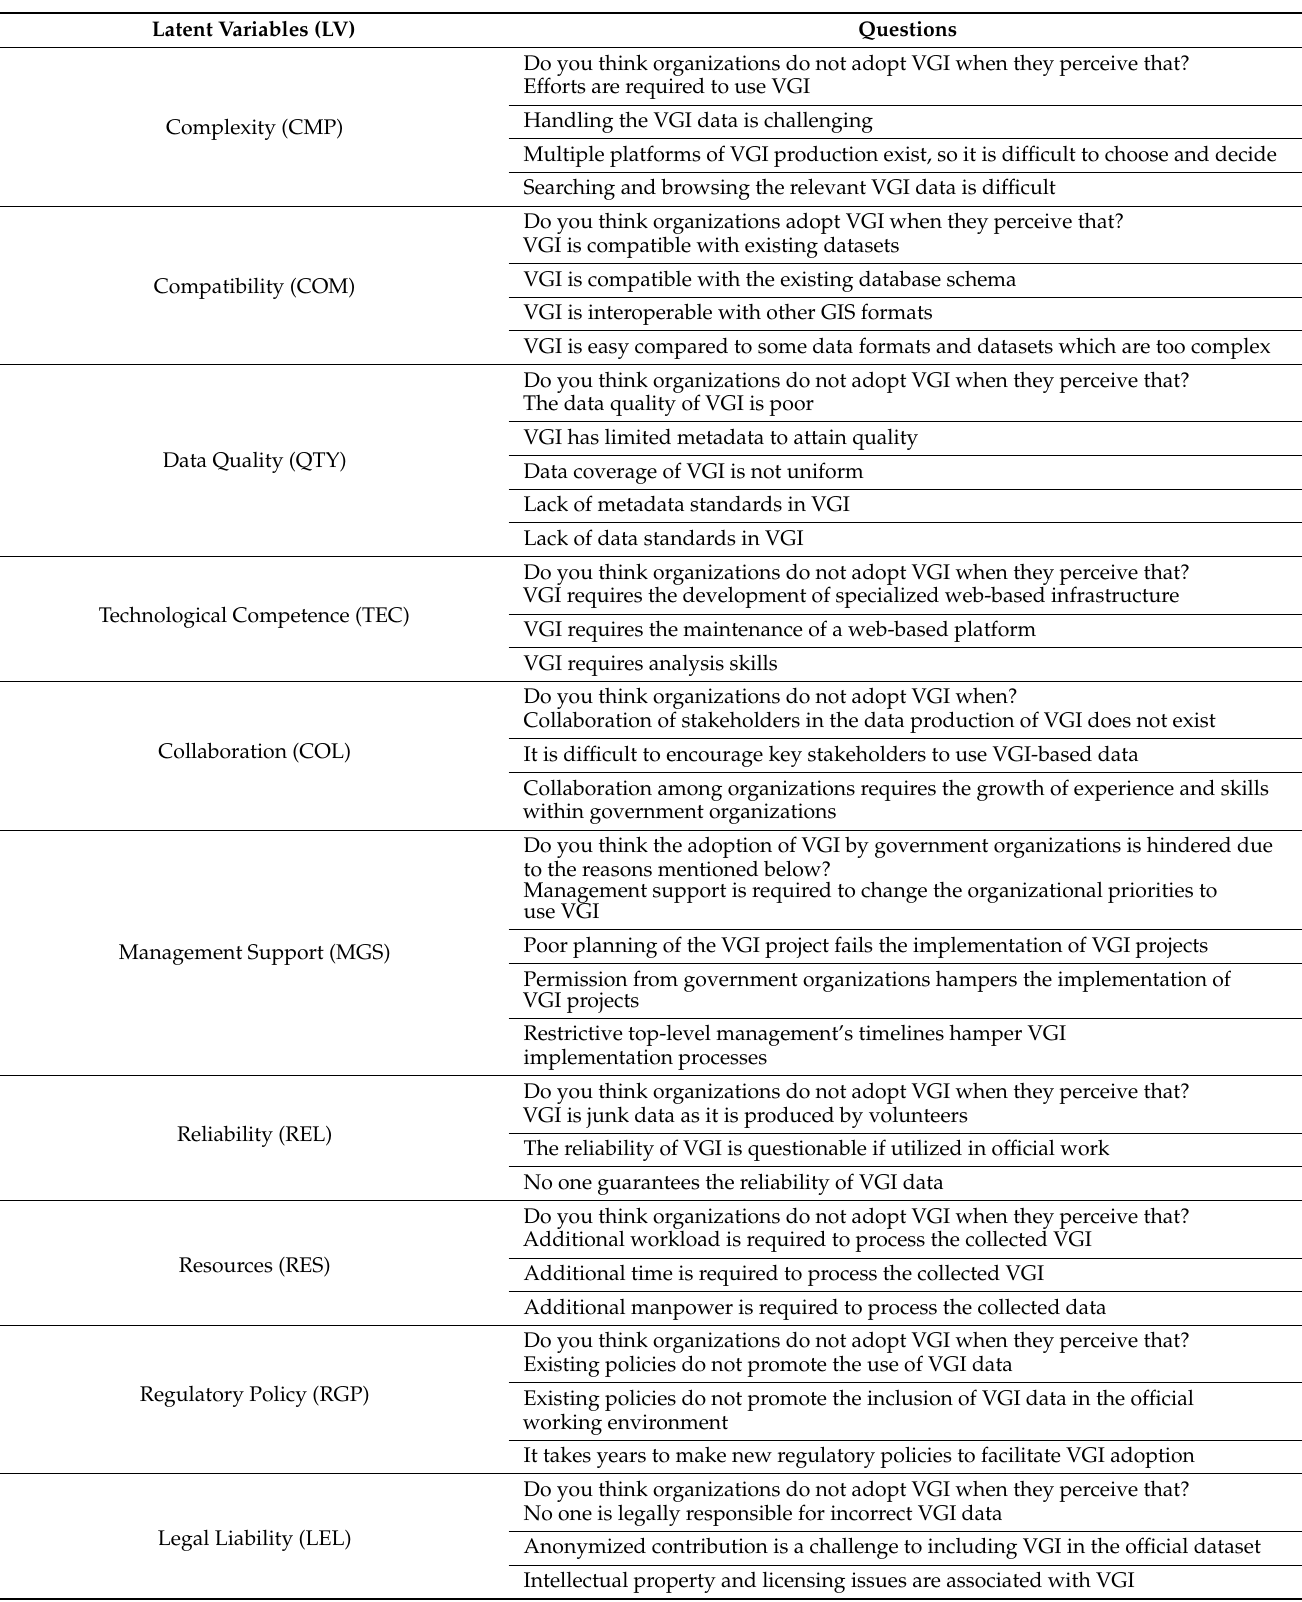
Table A1. A survey questionnaire was developed based on the questions formulated using the established